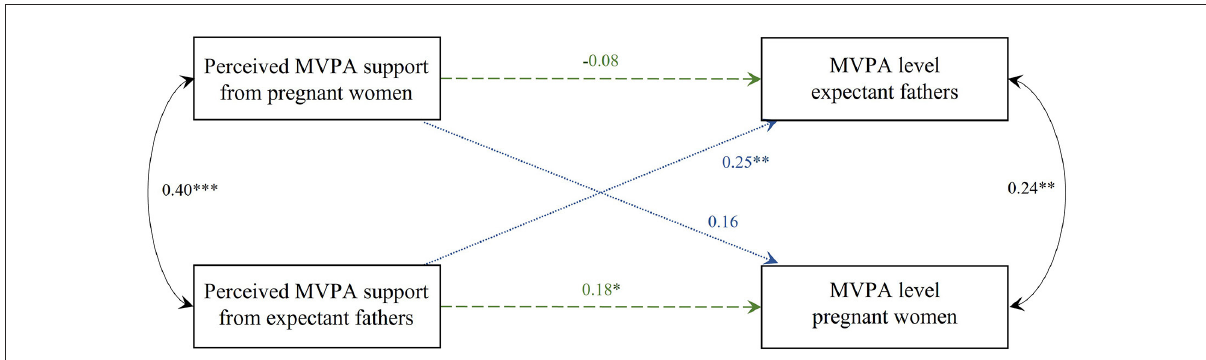
FIGURE3 Actor-Partner Interdependence Model of the relation between perceived MVPA support and MVPA levels in women and men. Standardized parameter estimates are shown, * p < 0.05; ** p < 0.01; *** p < 0.001. Model corrected for family income (between-dyad covariate), BMI and age (within-dyad covariates). Green dashed line, actor-effect; blue dotted line, partner-effect; MVPA, moderate-to-vigorous physical activity; BMI, body mass